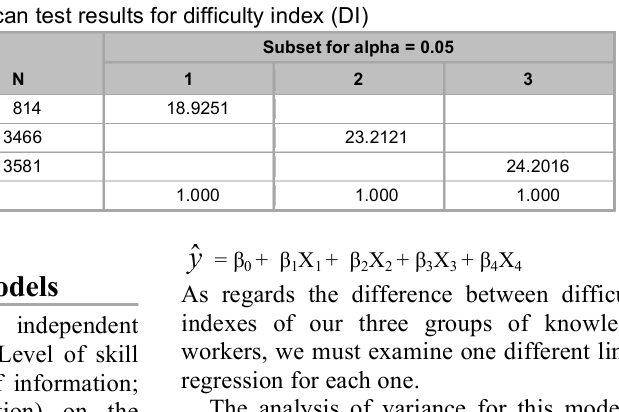
Duncan test results for difficulty index (DI)